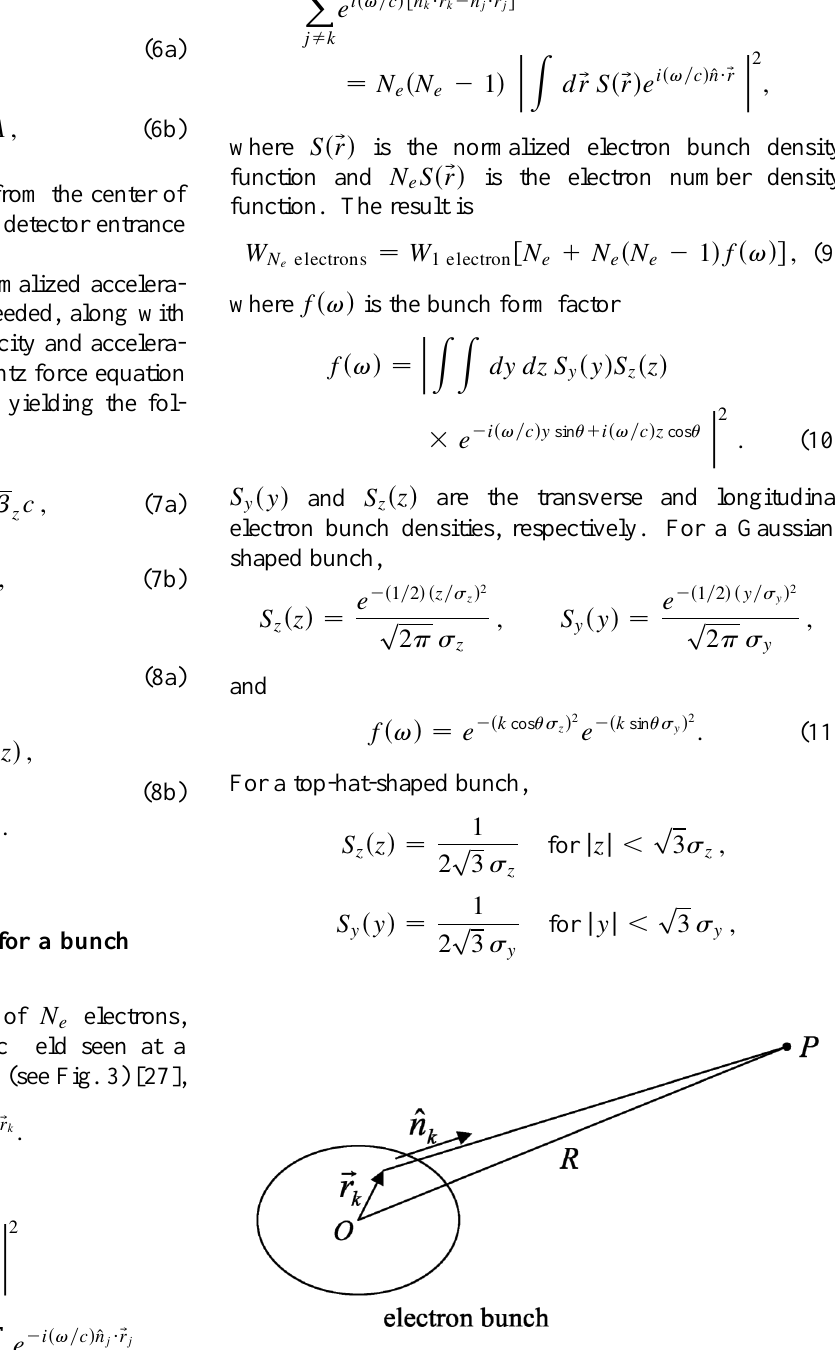
FIG. 3. Geometry for bunch form factor calculation. P is the point of observation, (cid:2) r k is the vector from the origin to the k th electron in the bunch, ˆ n k is the unit vector pointing from the k th particle to the point of observation, and R is the distance from the origin to the point of